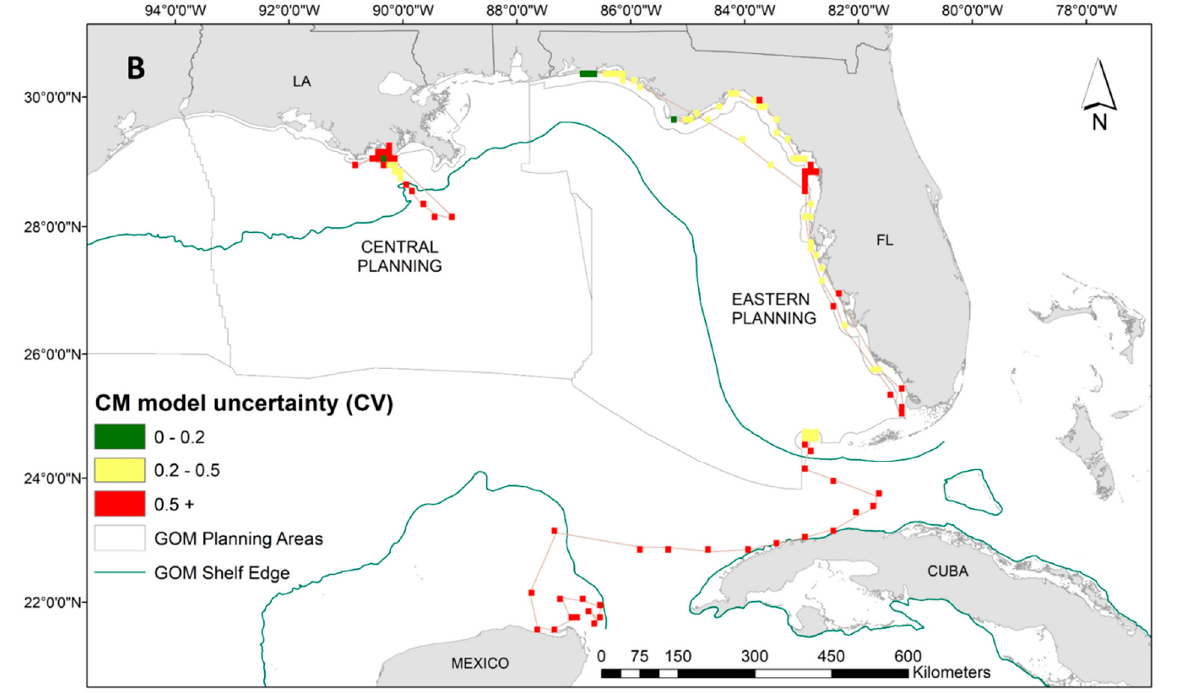
Figure 5. ( A ) Spatial predictions and ( B ) associated model uncertainty, represented by coefficient of variation (CV), for green turtles ( Chelonia mydas ) time-at-surface model. Time-at-surface predictions can be interpreted as a percentage of 100% for a 24 h observational time window. Predictions from both training and testing data are displayed but were generated independently.